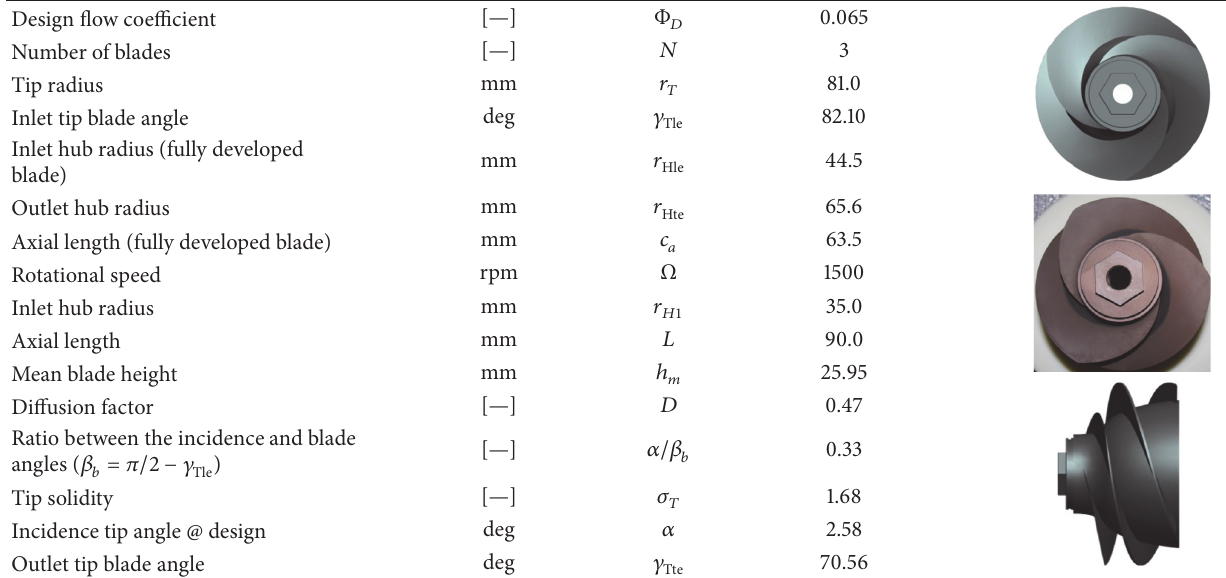
Table 2: Geometrical and operational parameters of the DAPROT3 inducer.